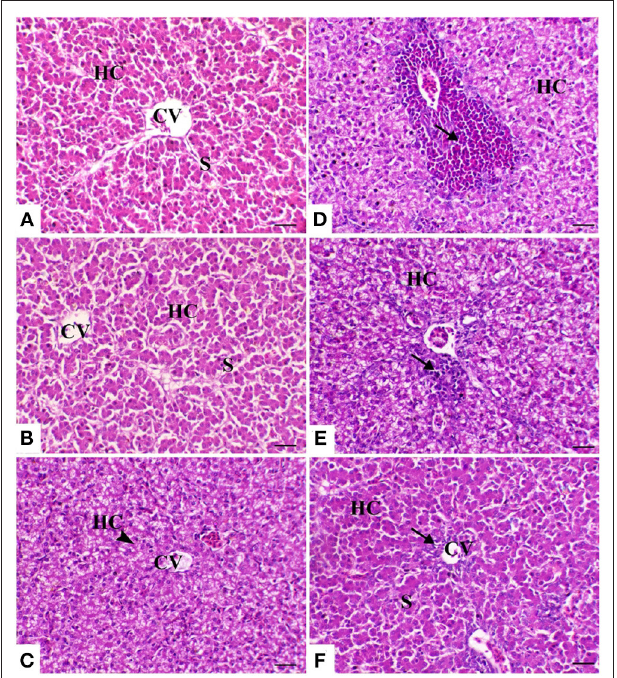
FIGURE 2 | Hepatic sections of the different treated groups. (A) Control group. CV, central vein; HC, hepatocytes; S, blood sinusoids. (B) Sham group R (the arrowhead indicates normal hepatocytes). (C) Sham group E. (D) Heat stress (HS) group (the arrow indicates periportal heterophilic infiltration). (E) HS + R (the arrow indicates mild periportal mononuclear cell infiltration). (F) HS + E (the arrow indicates a slight regeneration of the bile duct lining epithelium and mild inflammatory cell infiltration). H&E, × 200, bar = 50 µ m.